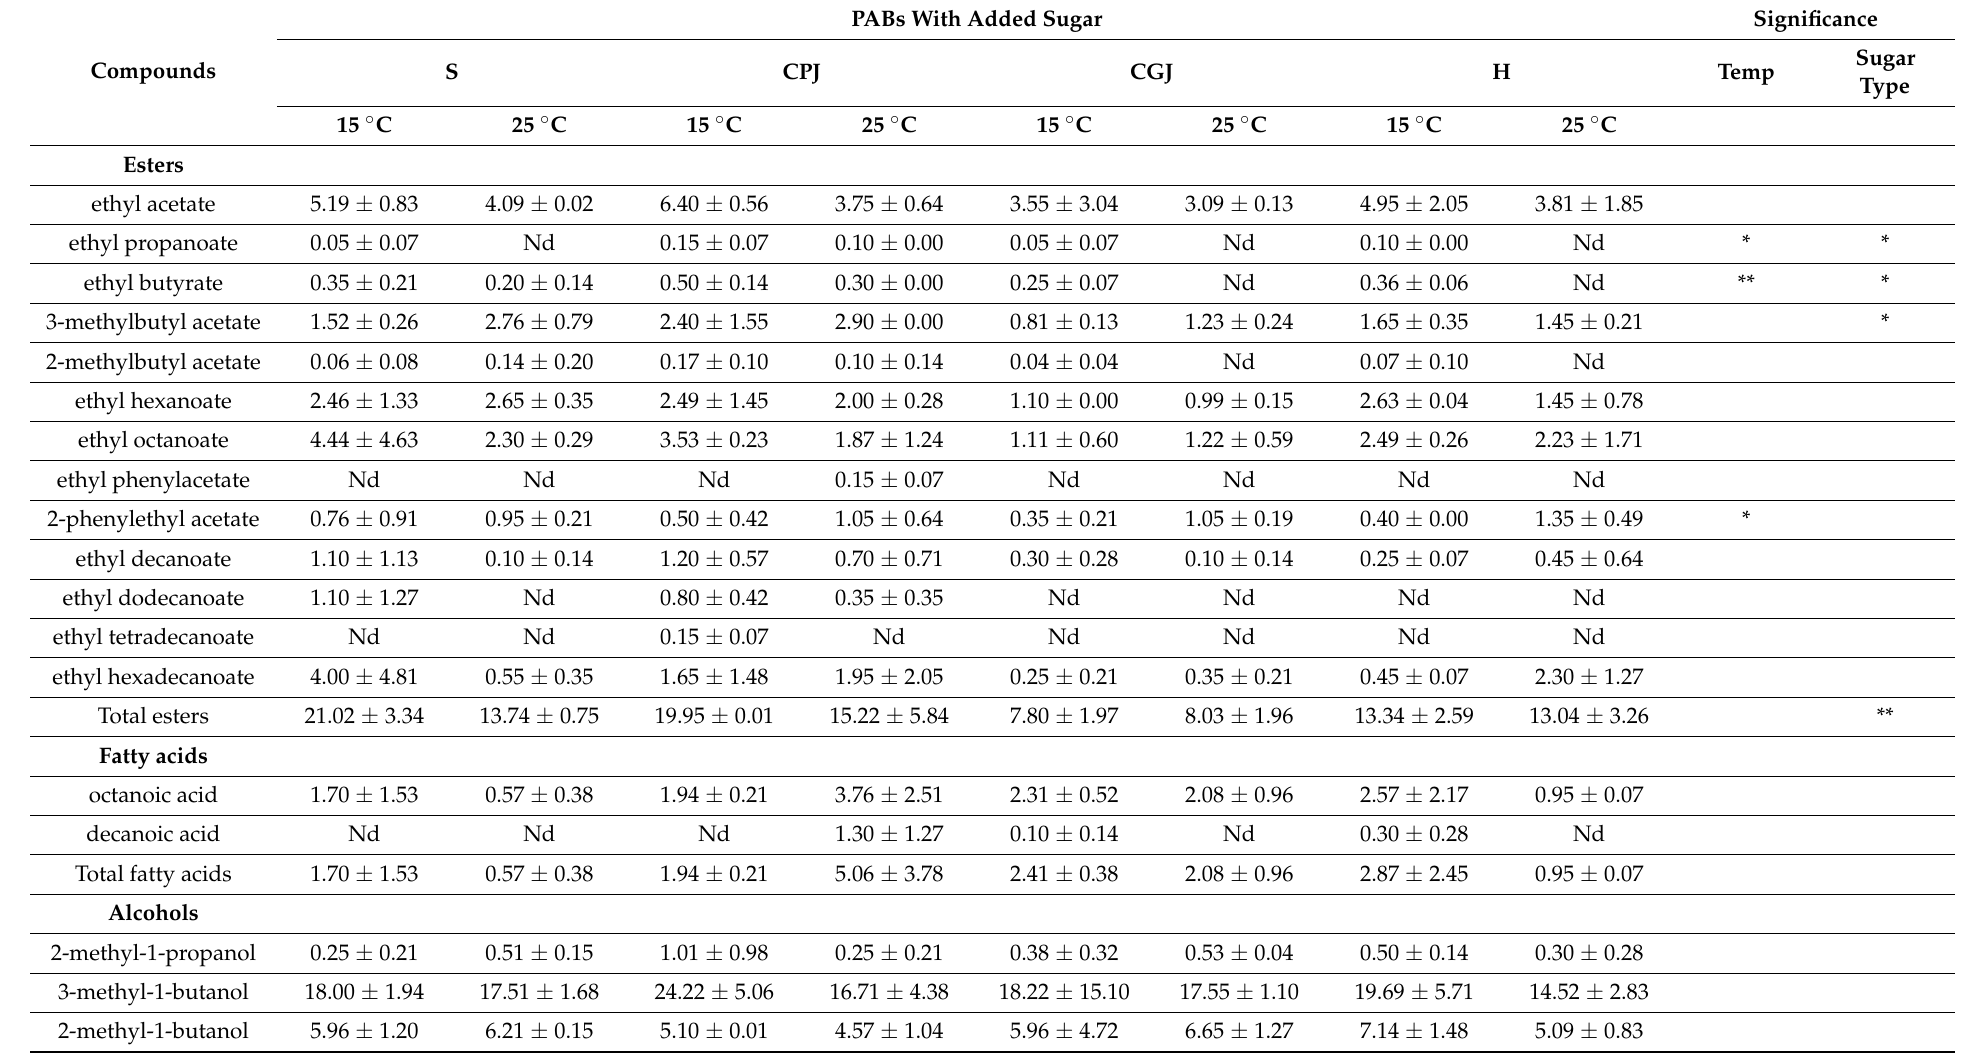
Table 3. Effect of sugar type addition and fermentation temperature on aroma-related compounds (mg L − 1 ) of